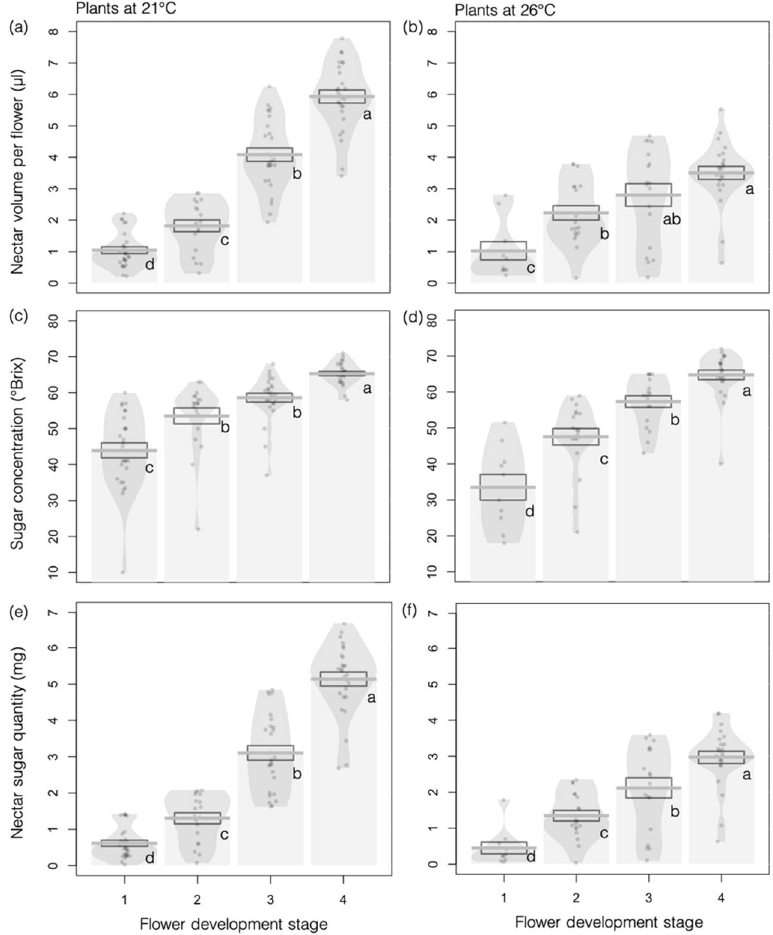
Figure 3. Effects of higher temperature on nectar production in Borago officinalis . ( a , b ) Nectar volume per flower (N = 178); ( c , d ) sugar concentration of nectar; and ( e , f ) total amount of nectar sugar (N = 173 for c–f) at the various flower developmental stages of plants grown at 21 °C ( a , c , e ) or 26 °C ( b , d , f ). Data are presented as means ± standard errors (SEs) as boxplots and with raw data points included in light gray.